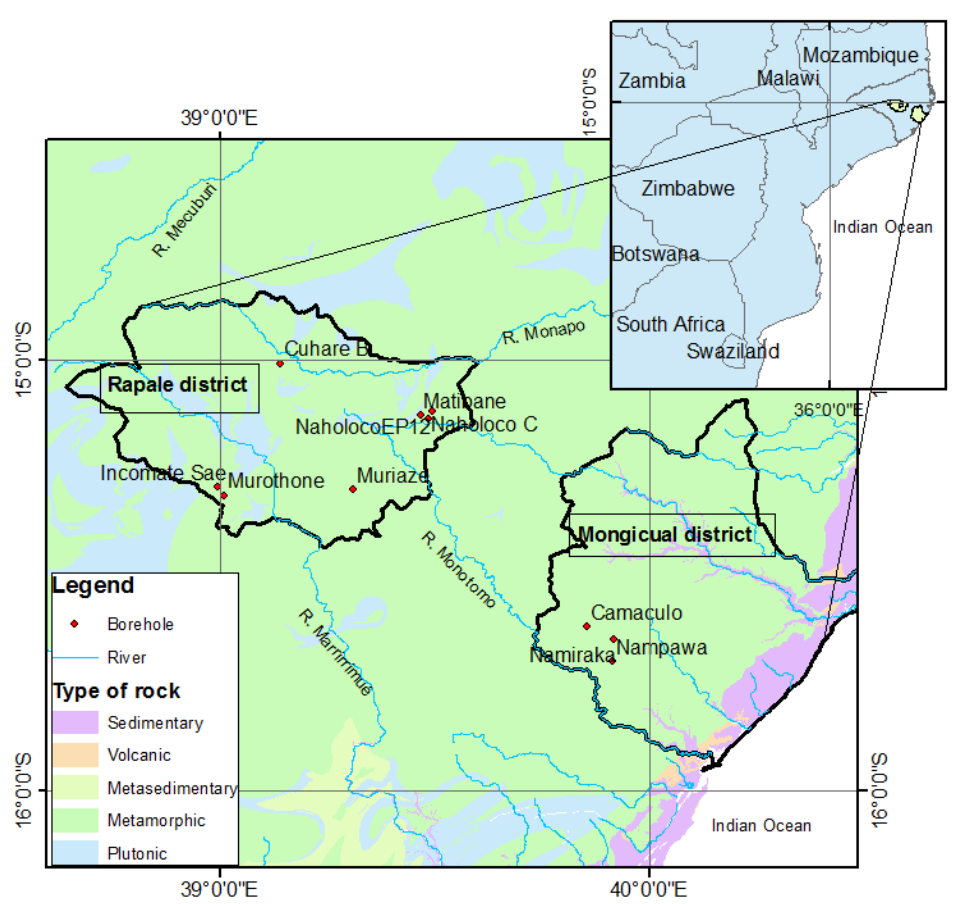
Figure 1. Regional geology and location of the study sites: Rapale district and Mongicual district (adapted from Geologia [10]).